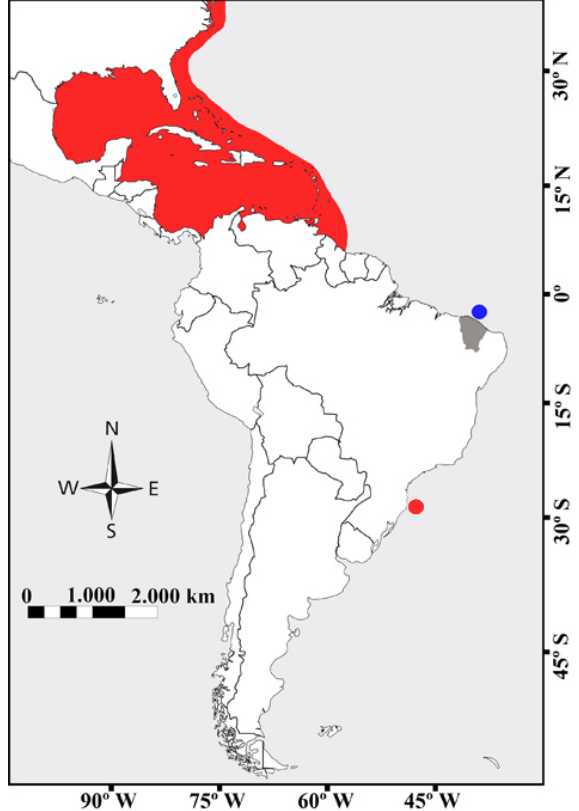
Stibarobdella macrothela Figure 2. Distribution map of in the Western et al. Atlantic Ocean. Red: Previous records. Distribution in the Northern et al. Hemisphere according to Llewellyn (1966), Sawyer (1975), Williams (1982) and Furiness (2007), and a single report from the Southern Hemisphere by Soto (2000). Blue: The two specimens reported here were collected off Paracuru, a coastal location in Ceará, Northeastern Brazil (3°25′31″ S, 39°1′29″